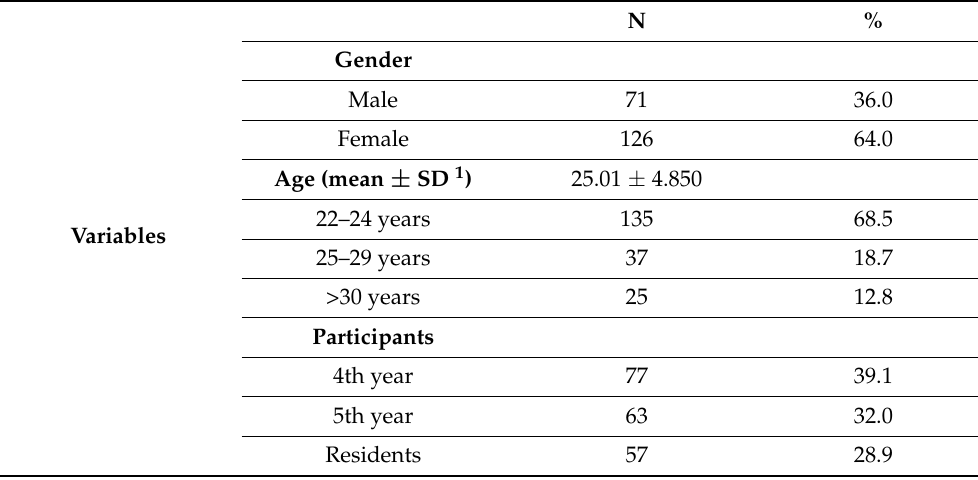
Table 1. Characteristics of study participants (N =